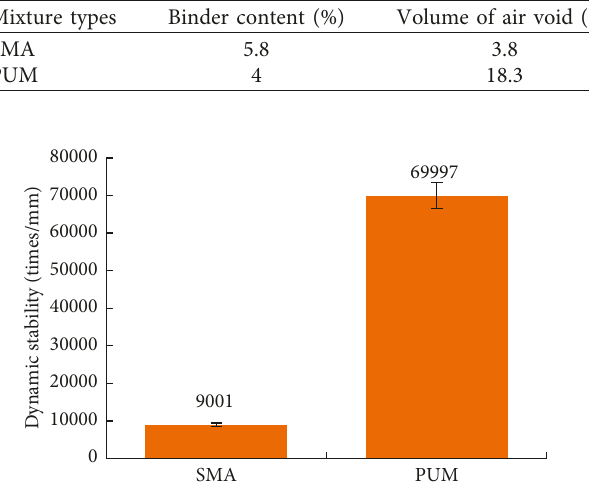
Figure 12: Results of the rutting tests.